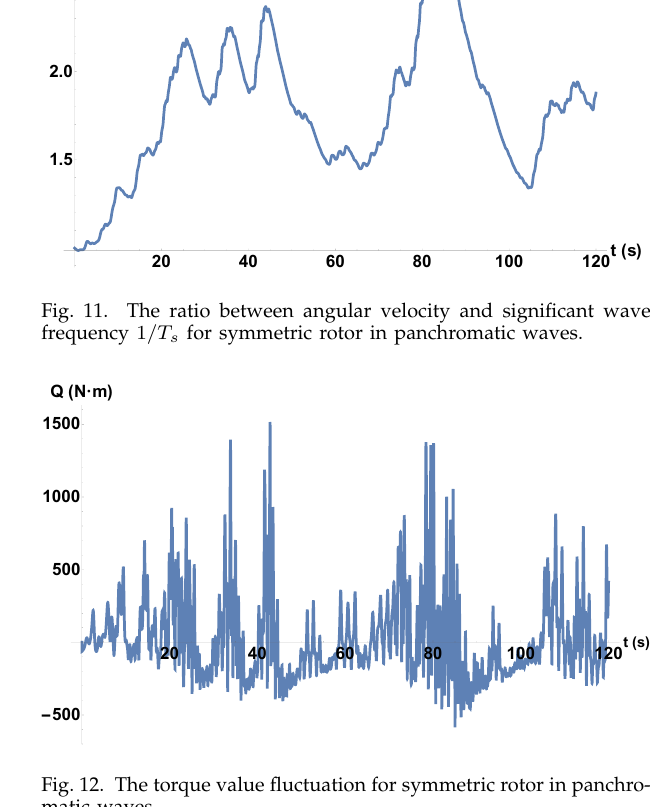
Fig. 8. The ratio between angular velocity and wave frequency for symmetric rotor in monochromatic waves.